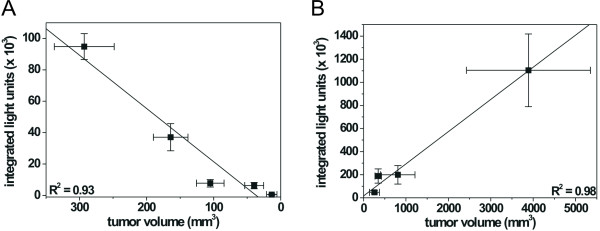
Linear regression analysis. Light emission as determined by the CCD camera was plotted against tumor volume. Mean values for all animals in a group along with the S.E.M are reported. (A) GCV treated mice: mice (n = 7) were imaged at start of therapy, after 1 and 2 weeks of GCV treatment, and 1 and 5 weeks after end of GCV therapy (R2 = 0.93, p = 0.008). In some mice additional images were acquired (Figure 5), but these were not included in this plot. (B) Saline treated control mice: these mice (n = 3) were imaged on days 7, 22, 29, and 35 and were sacrificed after the last BLI due to massive tumor growth (R2 = 0.98, p = 0.010).